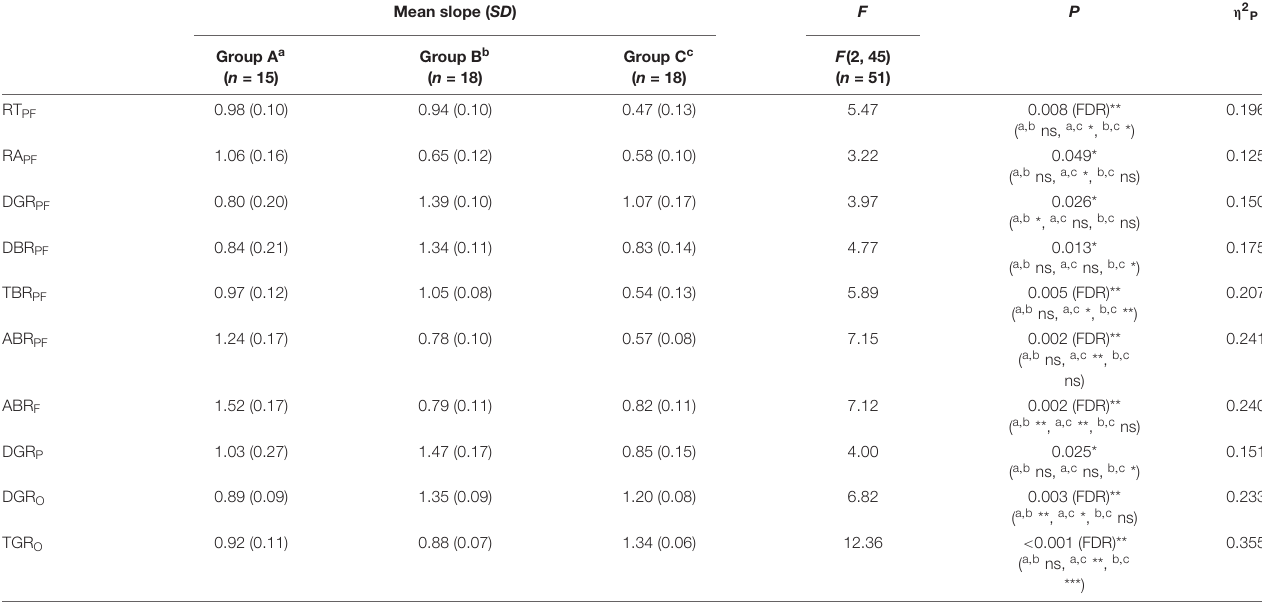
TABLE 3 | Mean and standard deviation ( S.D. ) of slope, F , and p -value of analysis of covariance (ANCOVA) on electroencephalogram (EEG)